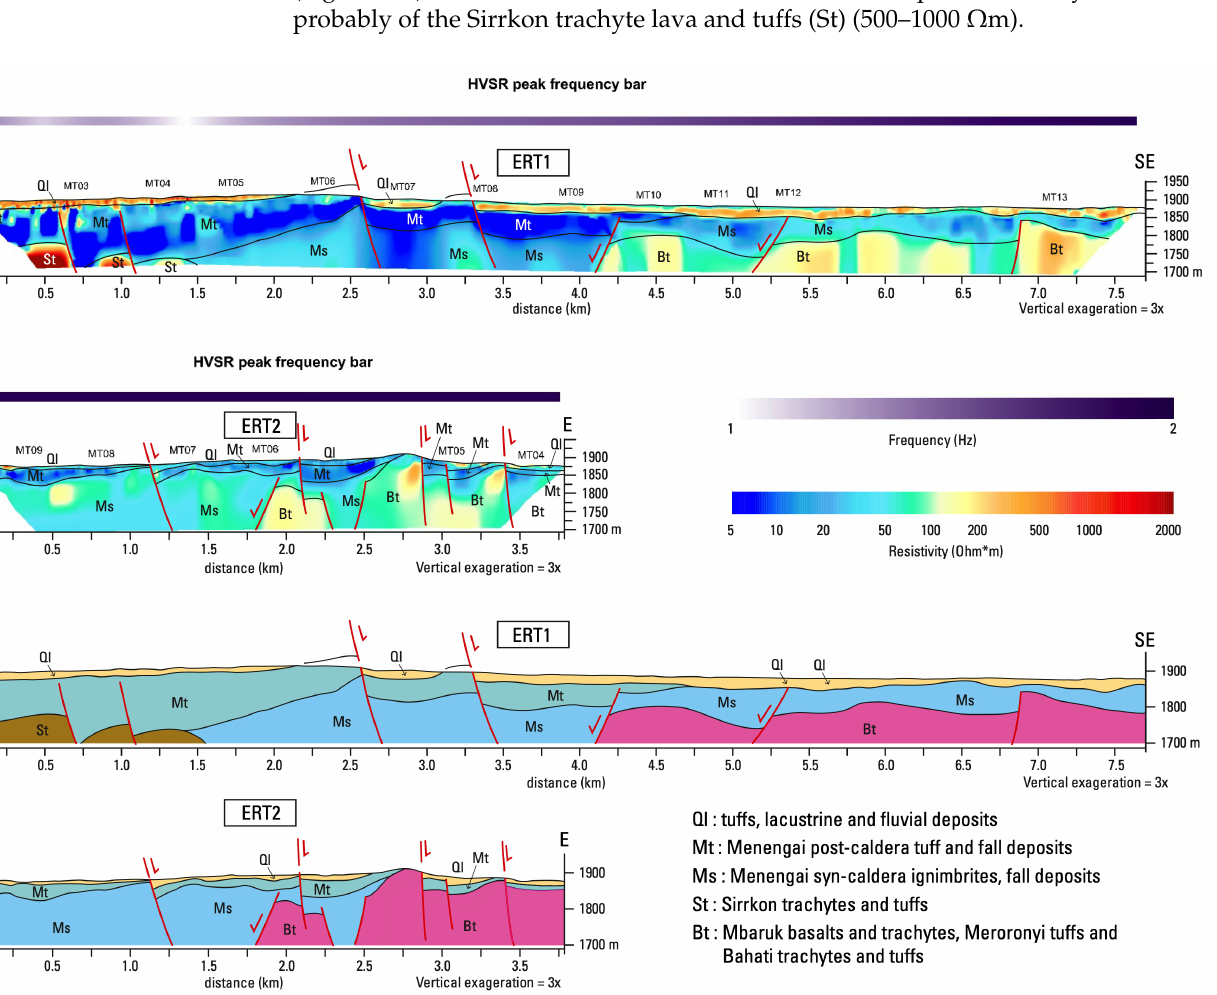
Figure 10. Cross sections with resistivity data, see Figure 5 for location. ( a , b ) ERT1 and ERT2 lines based on electrical resistivity tomography (ERT) data. ( c , d ), Geological